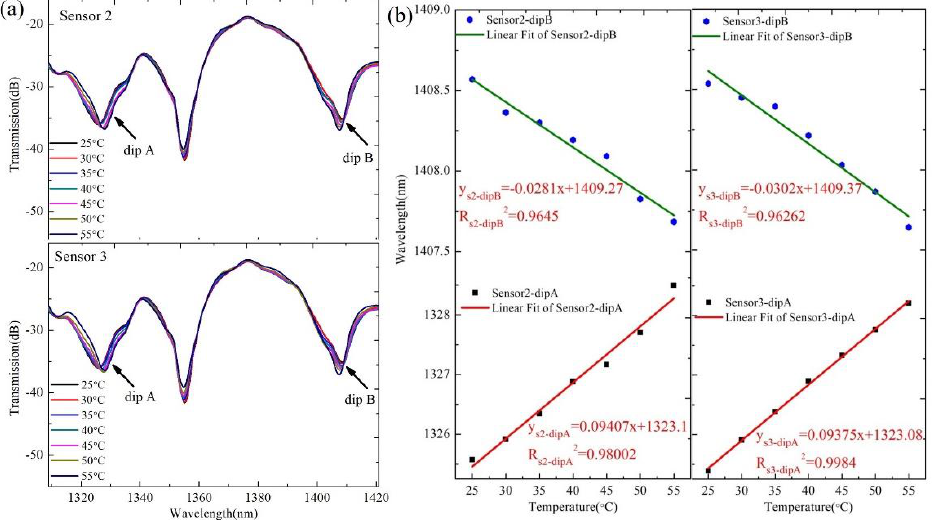
Figure 10. ( a ) The interference spectra of Sensor 2 and Sensor 3 at different temperature; ( b ) the wavelength shift trends for Sensor 2 and Sensor 3 under different temperature.